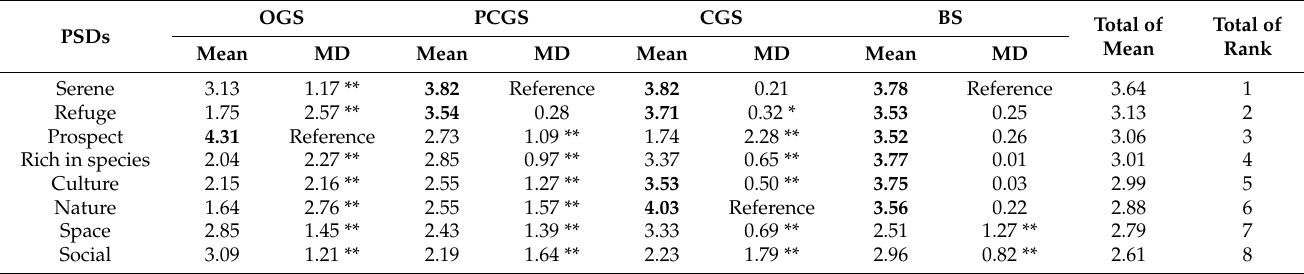
Table 3. Arithmetic means of perception of the eight PSDs in different landscape types.